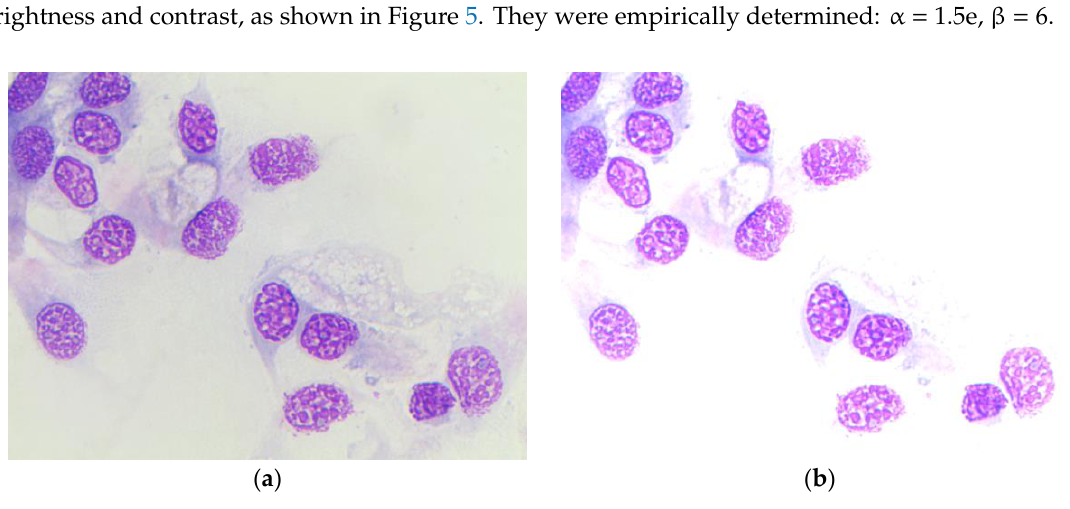
Figure 5. Input image ( a ), output image of brightness enhancement step ( b ).